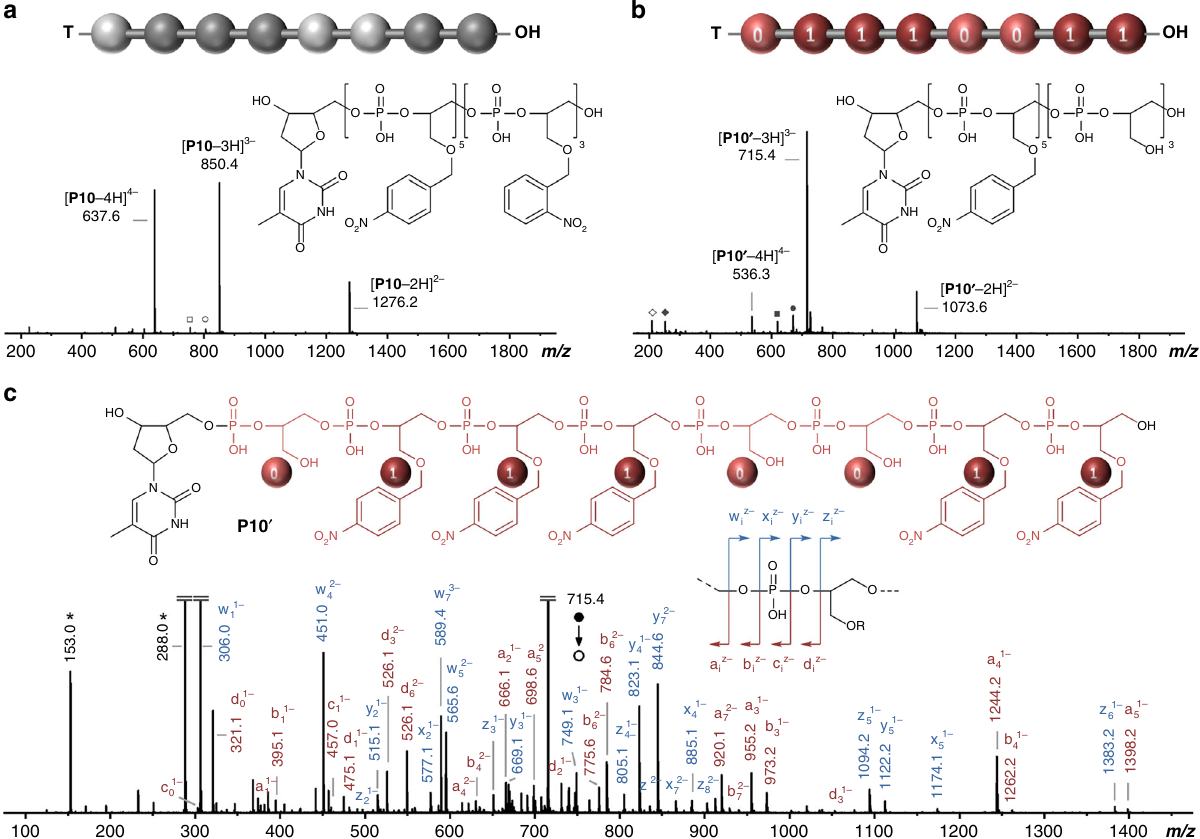
Fig. 3 Characterization of a digital polymer coded with an invisible monomer ink. ESI-HRMS spectra obtained in the negative ion mode for polymer P10 before ( a ) and after ( b ) light exposure. Squares and circles indicate synthesis impurities. Open and full dark gray diamonds indicate photo-deprotection by- products. See Supplementary Fig. 6 for interpretation. c MS/MS sequencing of the irradiated polymer P10 ′ . This spectrum was obtained by collision- induced dissociation of the [ P10 ′ -3H] 3 − precursor ion. The inset schematizes the fragmentation pattern of a phosphate repeat unit. Dark gray stars indicate secondary fragments including deprotonated repeat units at m/z 153.0 and m/z 1 H NMR spectroscopy (Supplementary Fig. 48), and ESI-MS